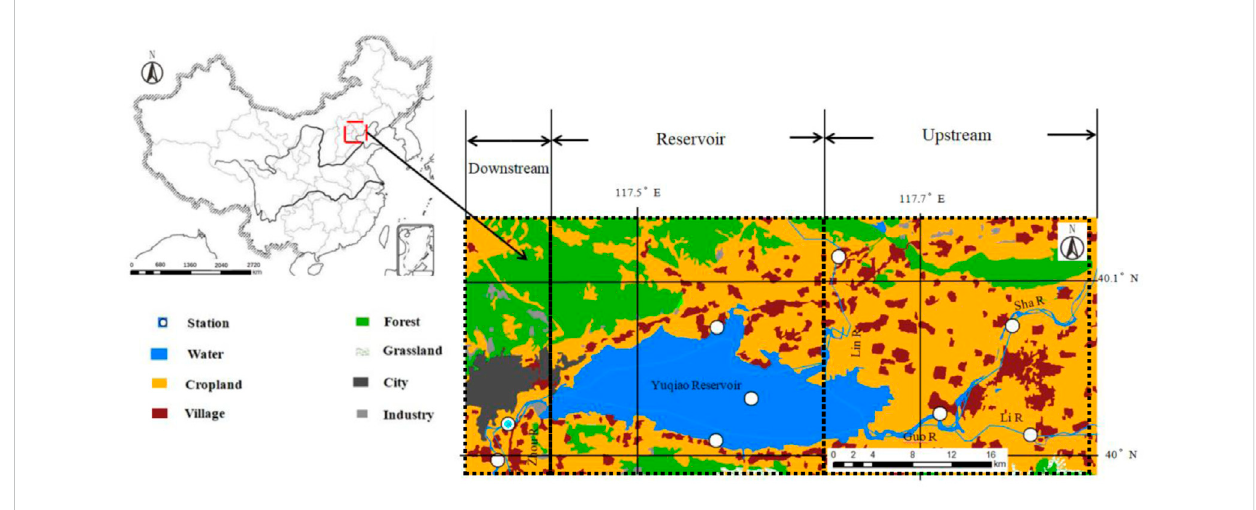
Land-use data image in the Yuqiao